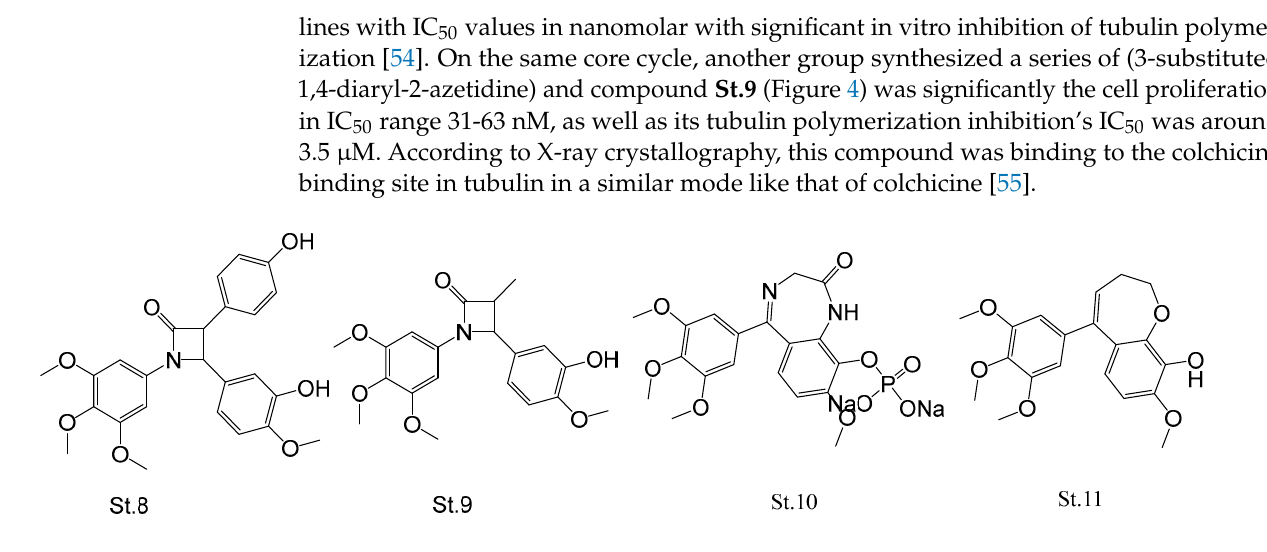
Figure 4. The structures of CA-4 analogues when the linker is replaced with heterocycles (four and seven-membered rings).